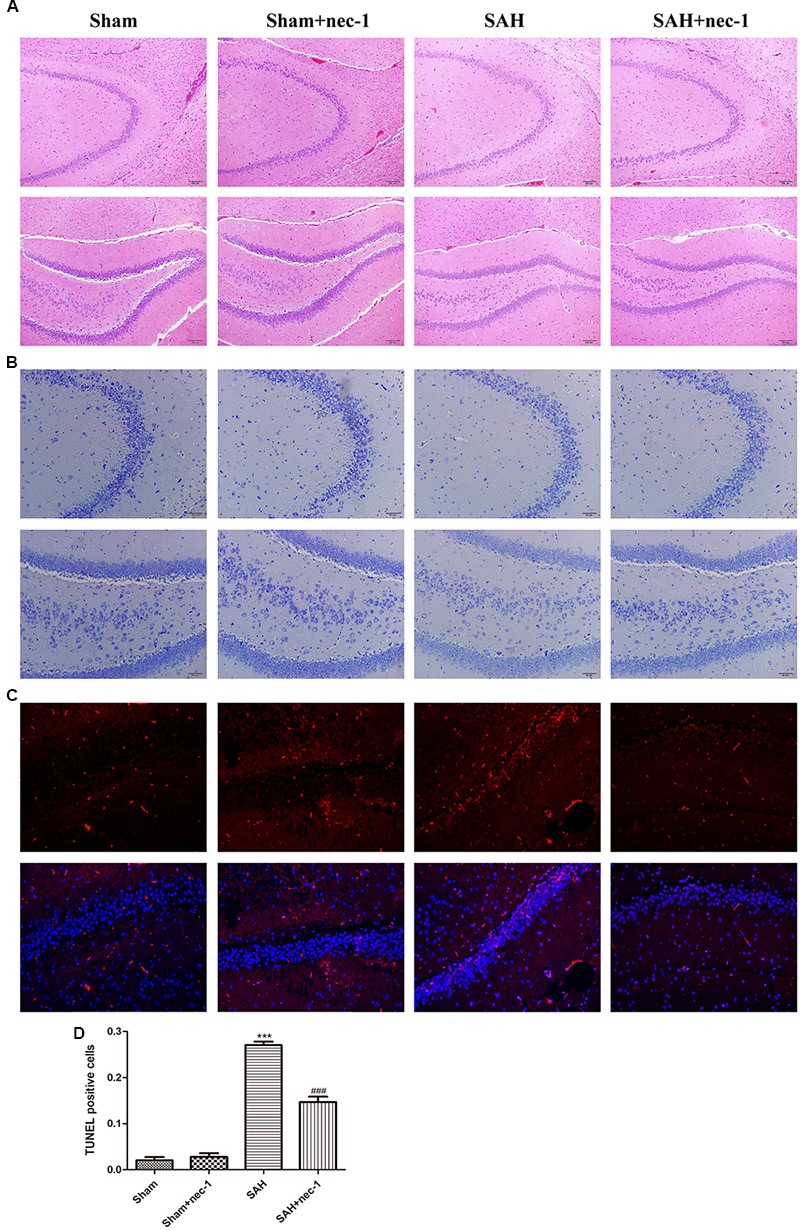
Nec-1 improves the pathological changes of the hippocampus after SAH. (A) In the H&E slices, the death of neurons and the damage to the hippocampus was clearly observed after SAH, both in amount of neurons and by the morphological structure of the hippocampus. Scale bar = 100 μm. (B) In the Nissl slices, the death of neurons and the damage of hippocampus was also clearly observed; the structure of the hippocampus was destroyed both in the CA3 and DG areas. Scale bar = 50 μm. (C,D) In TUNEL staining, the SAH group showed more TUNEL-positive cells than the Sham group. In the Sham+nec-1 group, the number of TUNEL-positive cells decreased compared to the SAH group. ∗∗∗P < 0.001, Sham vs. SAH, ###P < 0.001, SAH+nec-1 vs. SAH.